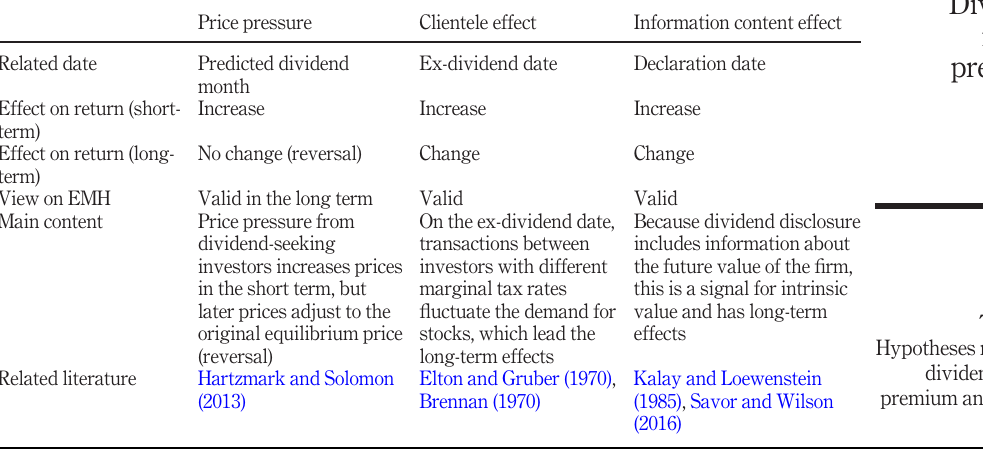
Table 1. Hypotheses related